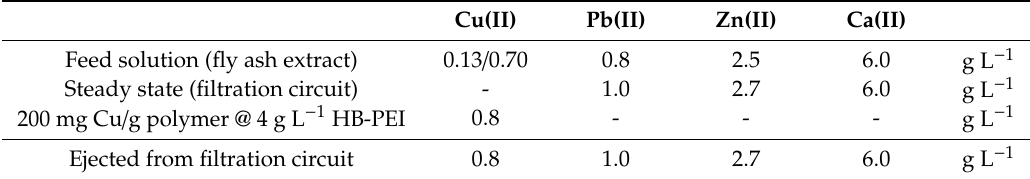
Table 4. Concentration of Pb(II), Zn(II), and Ca(II) in feed solution and filtration circuit in steady state. Composition of concentrate ejected from retention step if loading of 200 mg Cu / g polymer is accepted.